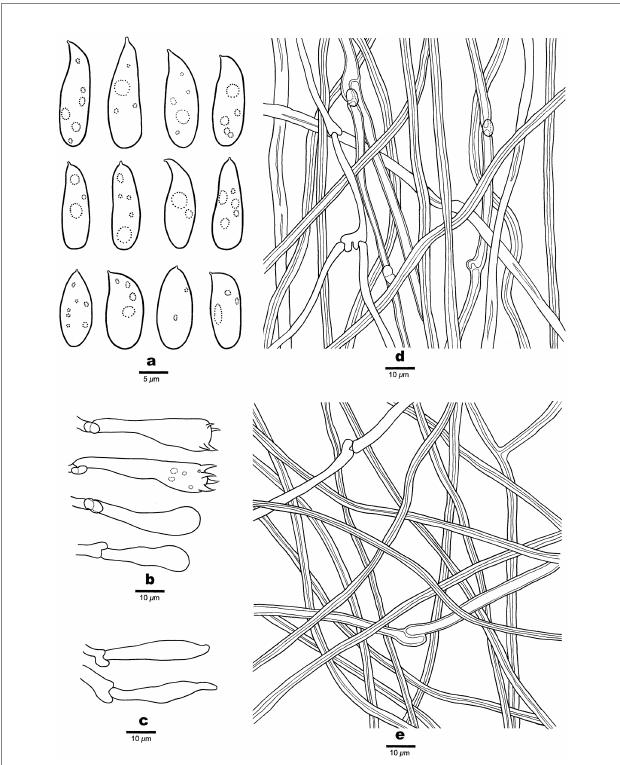
FIGURE 5 Microscopic structures of Antrodia variispora (holotype, Dai 23995). (A) Basidiospores. (B) Basidia and basidioles. (C) Cystidioles. (D) Hyphae from trama. (E) Hyphae from